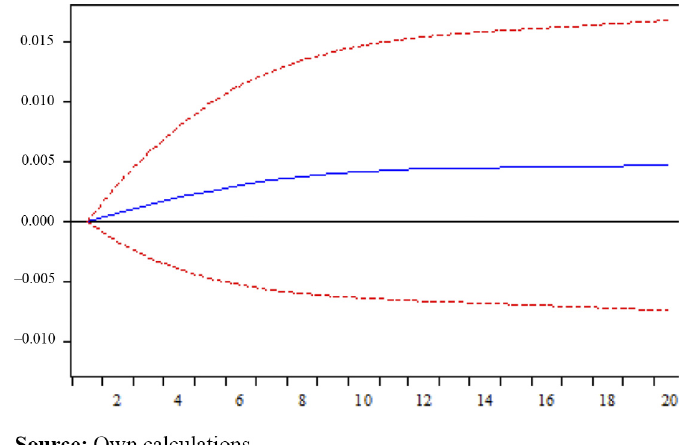
Figure 9. Response of LGDP to